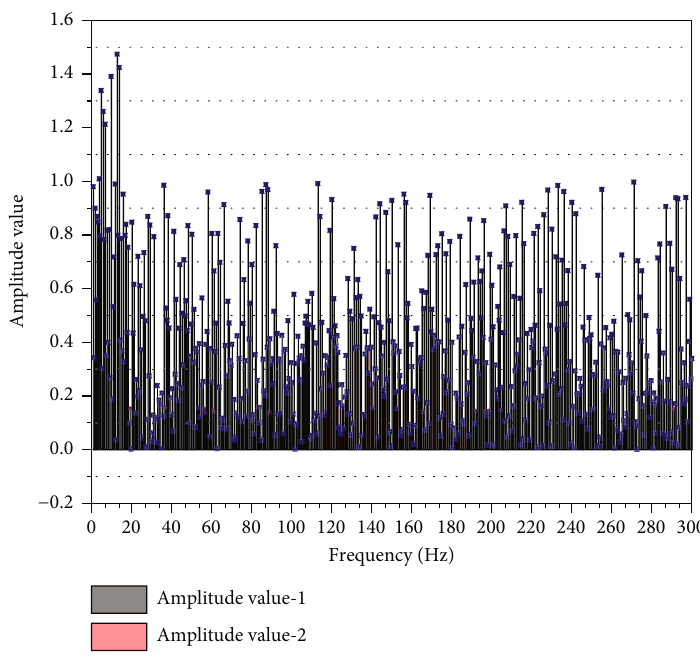
Figure 4: Speech spectrogram of timbre and